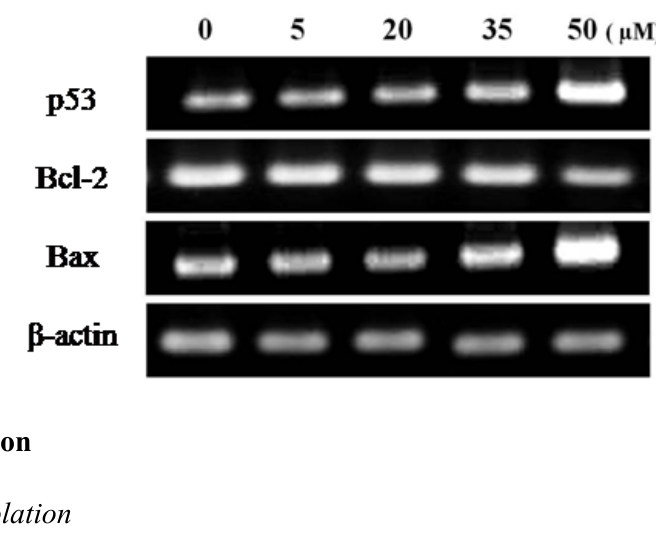
Figure 8. RT-PCR for anti-cancer effects on MCF-7 cells with treatment of